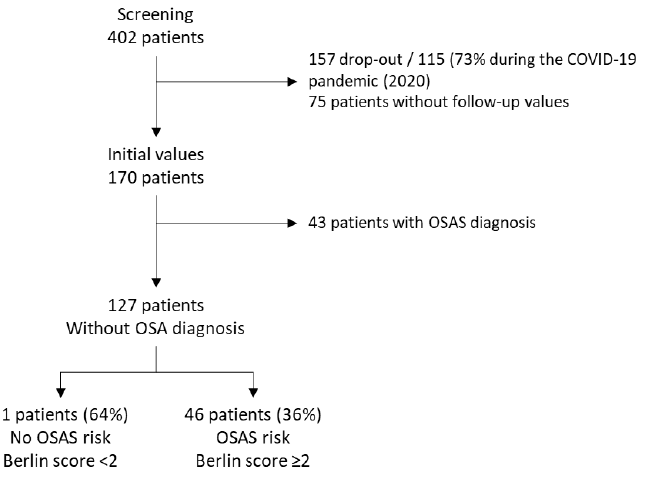
Figure 2. Flow chart of the study.